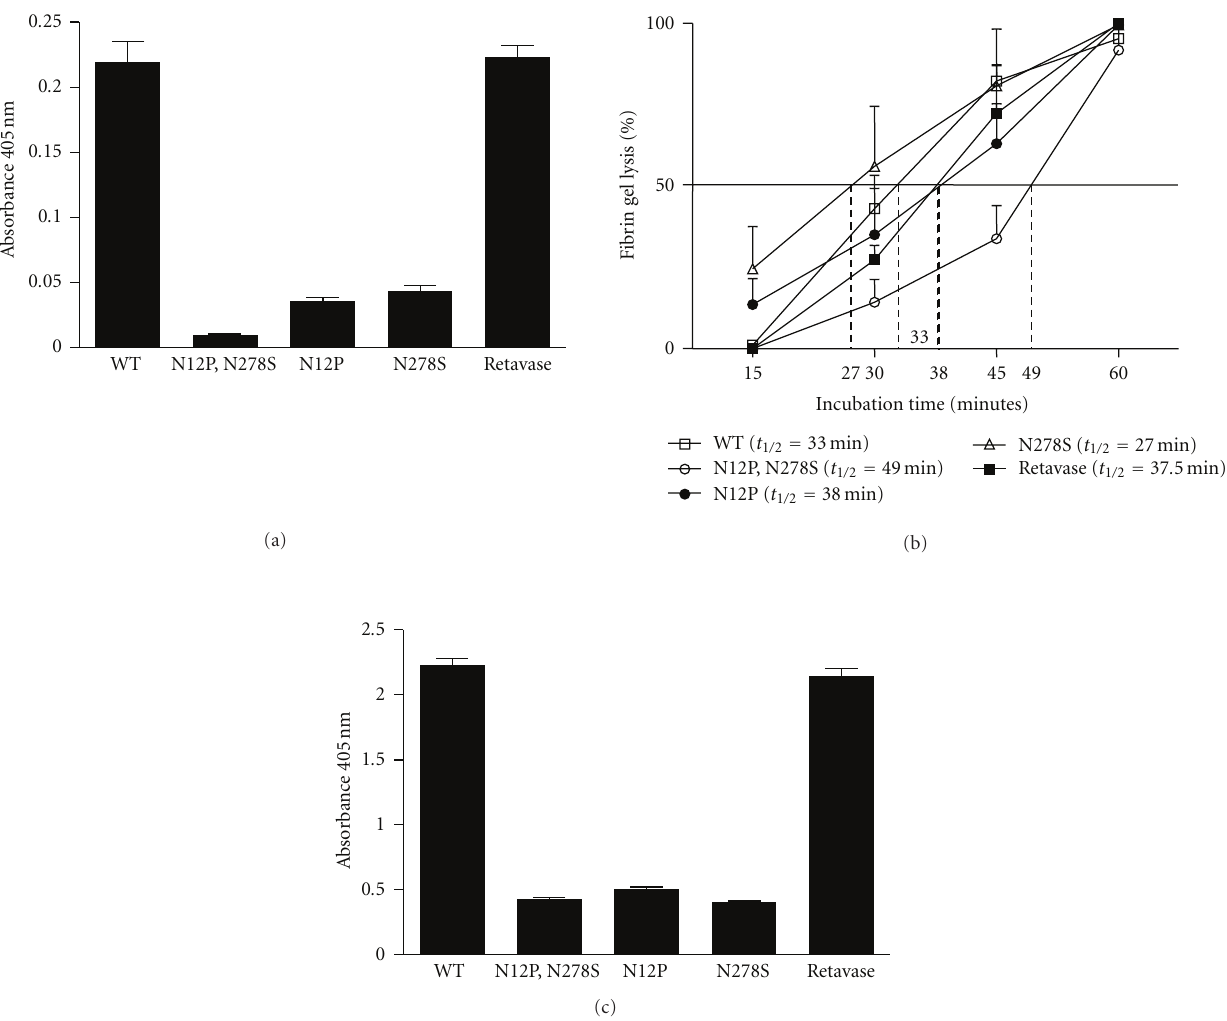
Figure 6: (a) Protease activity assay for rPA and its mutants. Sample 1 is WT (wild type rPA gene); sample 2: N12P, N278S double mutant; sample 3: N12P mutant; sample 4: N278S mutant; sample 5: commercial retavase preparation. (b) Clot lysis activity by turbidimetric fibrinolytic assay. X axis shows incubation time in minutes for clot lysis while Y axis shows % clot lysis. The horizontal line indicates 50% clot lysis while the vertical dotted lines indicate the t 1 / 2 values of di ff erent rPA samples. The course of clot lysis is demonstrated by connecting data points of di ff erent time intervals. (c) Plasminogen activation assay. X axis shows sample types while Y axis shows absorbance at 405 nm. Sample 1: WT rPA; sample 2: N12P, N278S double mutant; sample 3: N12P mutant; sample 4: N278S mutant; sample 5: commercial retavase